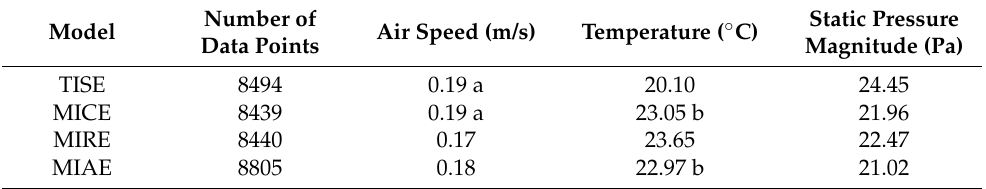
Table 7. Means of environment parameters at Plane F in four models. Note all the differences